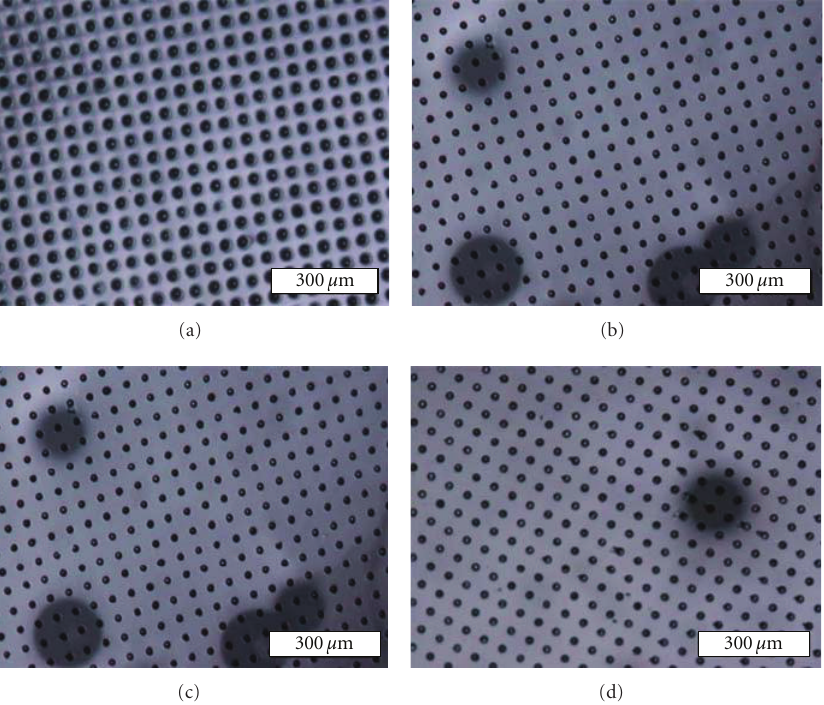
Figure 20: The PDMS optical film of no. D20-B microlens array (a) the first scale (34 µ m), (b) the second scale (23 µ m), (c) the third scale (13 µ m), and (d) the forth scale (6 µ